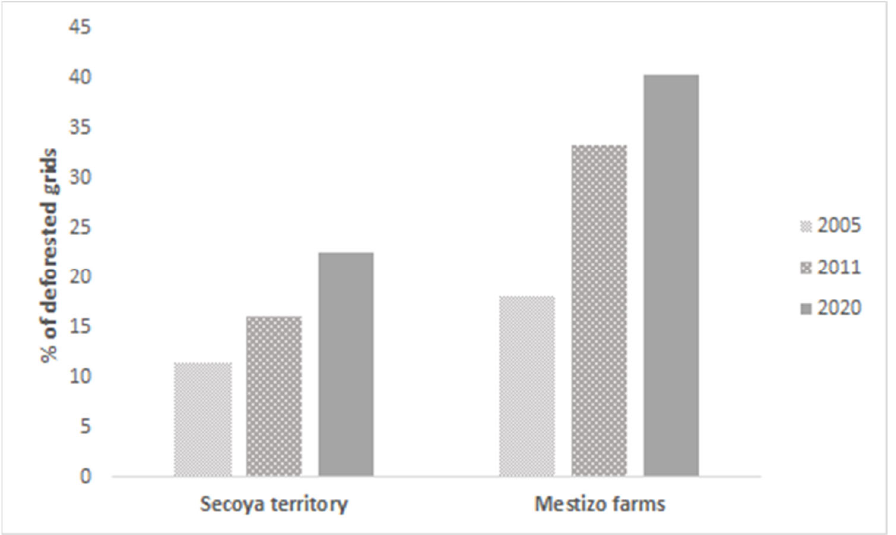
Figure 3. Deforestation trends, estimated by the percentage of deforested 500 × 500 m grids in 3 km 2 areas in the Secoya territory and in nearby “mestizo” farms, in 2005, 2011, and